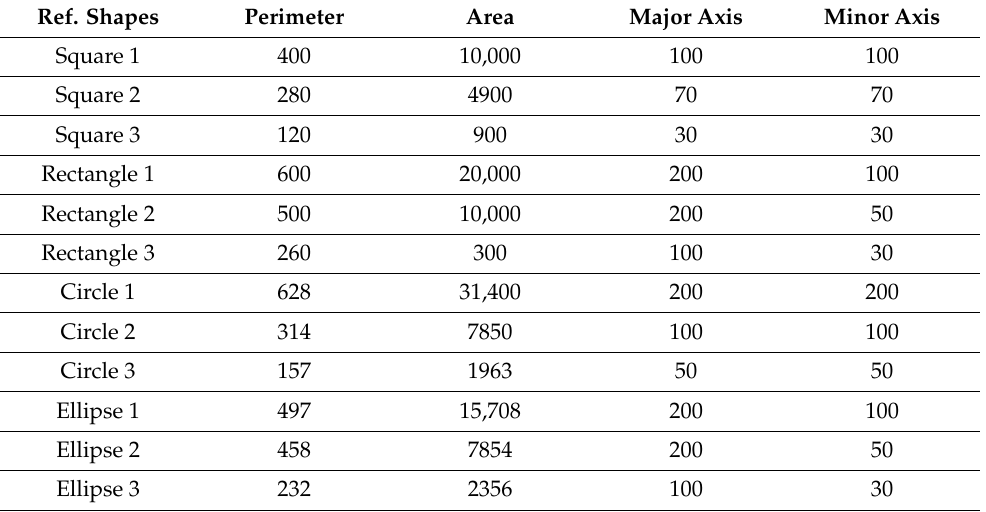
Table 1. Nominal characteristics, in pixels, of the test figures reported on the reference picture (from top ‐ left to bottom ‐ right).